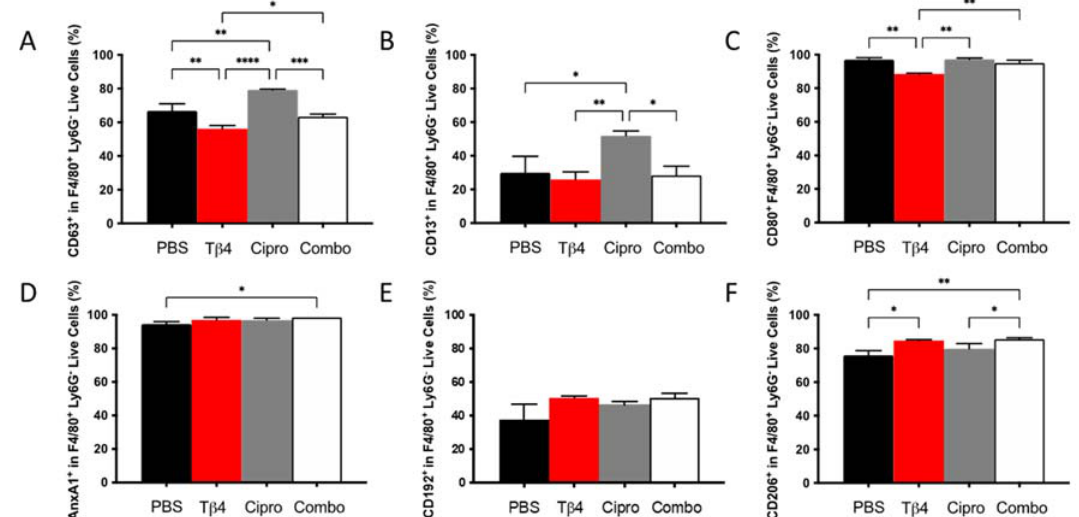
Figure 3. Cell surface marker expression as detected on M Ф by flow cytometry. Expression of select pro ‐ inflammatory molecules CD63 ( A ), CD13 ( B ), CD80 ( C ) and anti ‐ inflammatory molecules AnxA1 ( D ), CD192 ( E ), CD206 ( F ) was assessed from M Ф subpopulations in corneas of PBS ‐ , T β 4 ‐ , cipro ‐ , and combo ‐ treated B6 mice at 3 days after infection. Results are shown as averages of singlet populations for CD45 + F4/80 + Ly6G − M Ф . N = 5 corneas/group; * p < 0.05, ** p < 0.01, *** p < 0.001, **** p < 0.0001.